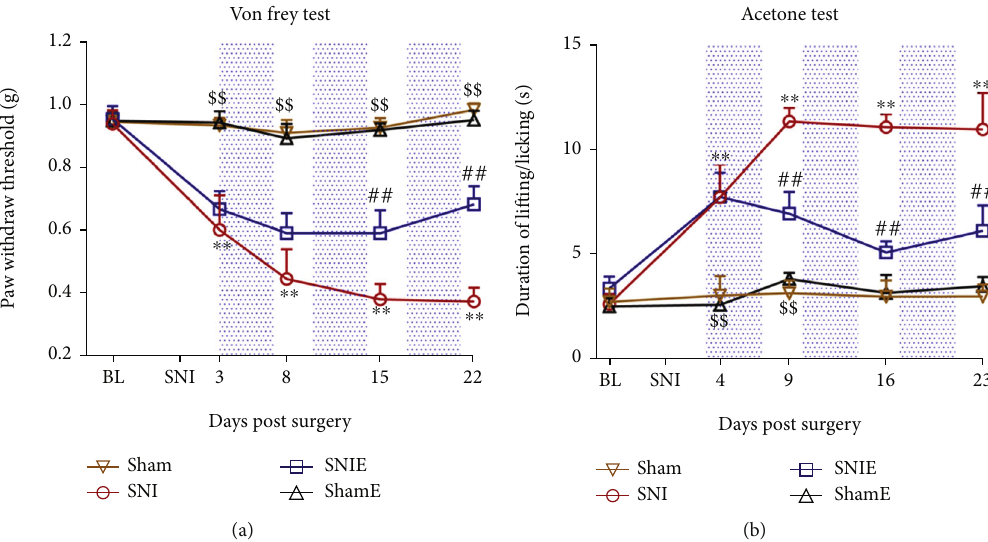
Figure 2: Treadmill exercises improve neuropathic pain behavior. (a) Mechanical allodynia test ( n = 8 ). (b) Cold allodynia test ( n = 8 ). Values represent the mean ± SEM ; ∗∗ P < 0 : 01 versus the sham group, ## P < 0 : 01 versus the SNI group, and $$ P < 0 : 01 versus the SNIE